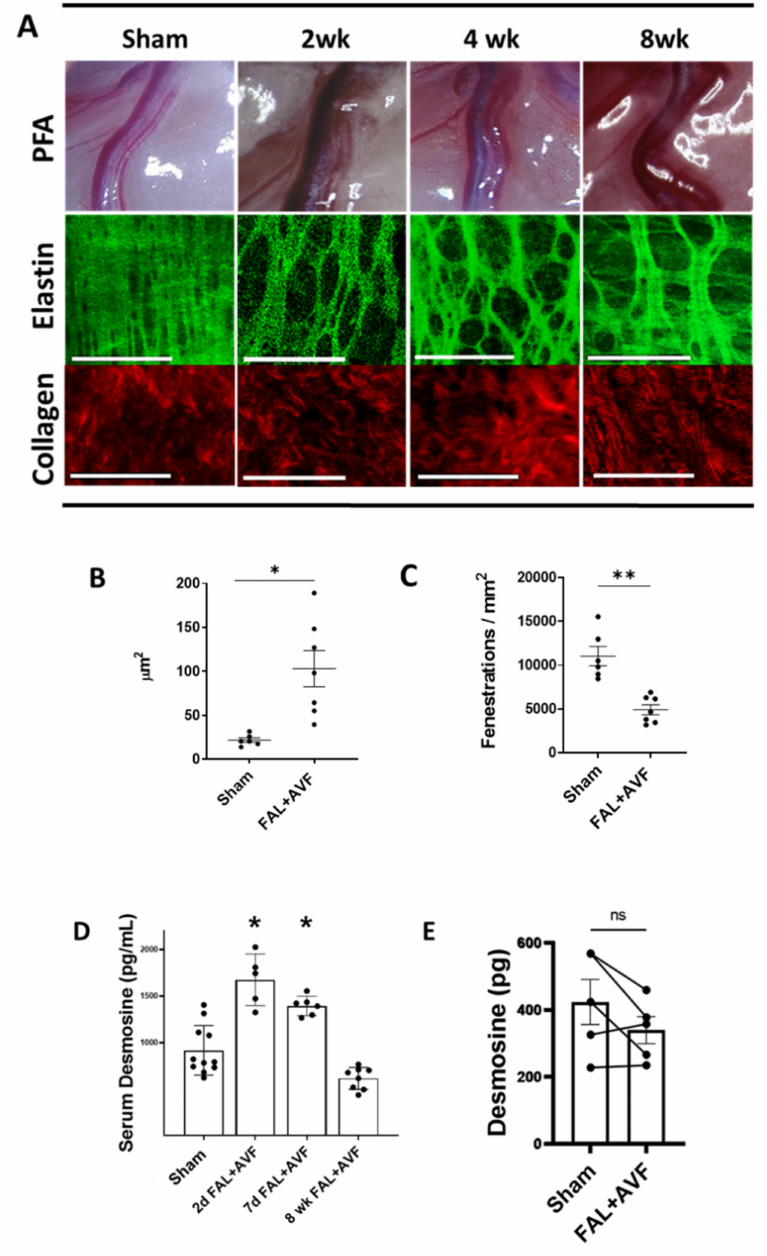
Figure 2. Structural remodeling of the ECM in arteriogenesis. ( A ) Gross and multiphoton microscopic images of PFAs isolated from rats undergoing FAL + AVF or sham operation at various time points. IEL characteristics of fenestration size ( B ) and fenestration density ( C ) were quantified from image stacks for FAL + AVF PFAs ( n = 7 vessels imaged, range 4–8 weeks post-FAL + AVF) and compared to the contralateral sham PFAs ( n = 6 vessels imaged). Analysis by two-tailed t -test. * p < 0.005, ** p = 0.003, compared to sham PFA. Bar = 50 µ m. Images acquired with Olympus FV1000MPE utilizing 830 nm laser. ( D ) Serum obtained from FAL + AVF animals at indicated time points was measured for desmosine content by ELISA and compared with serum obtained after sham operation. Analysis by one-way ANOVA with Tukey’s multiple comparison test ( n = 5–11 animals, * p ≤ 0.001 compared with control). ( E ) Isolated PFAs underwent acid hydrolysis and desmosine content was quantified via ELISA, n = 5 vessels ( p = 0.13, two-tailed paired t